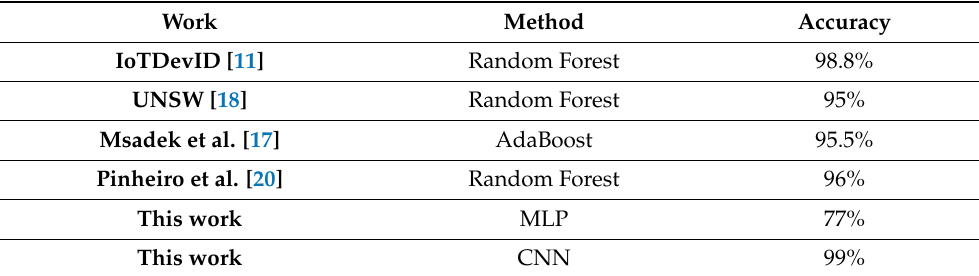
Table 11. Comparison of different